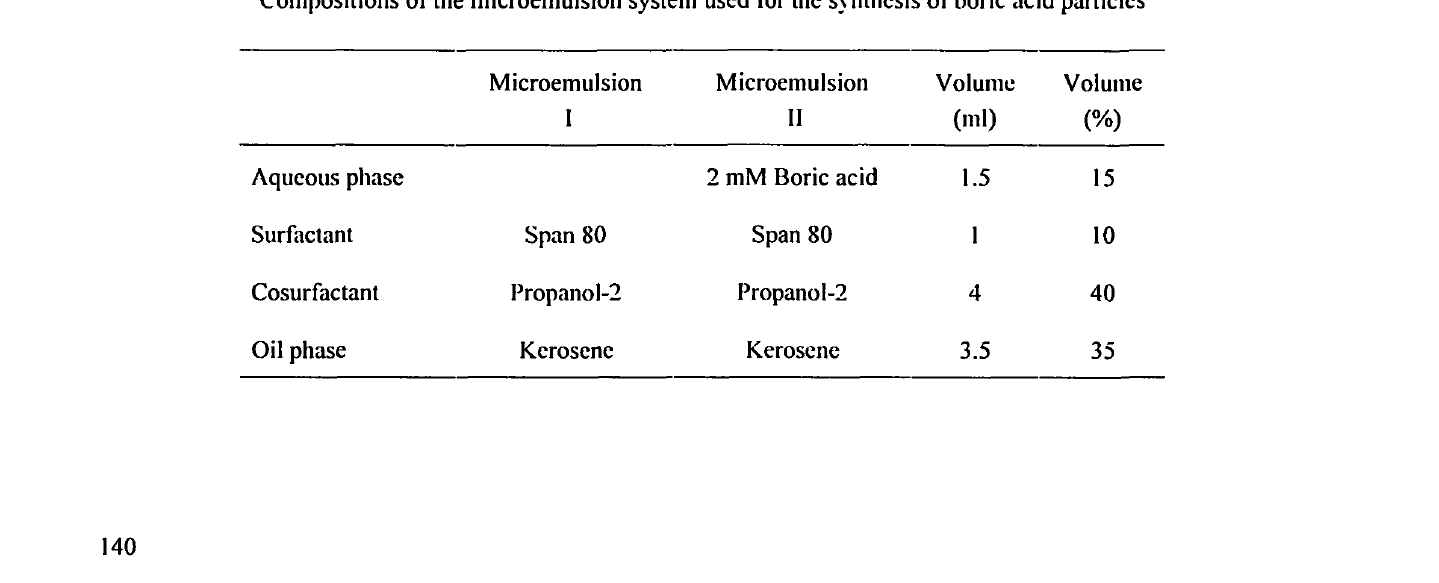
Compositions of the microemulsion system used for the synthesis of boric acid